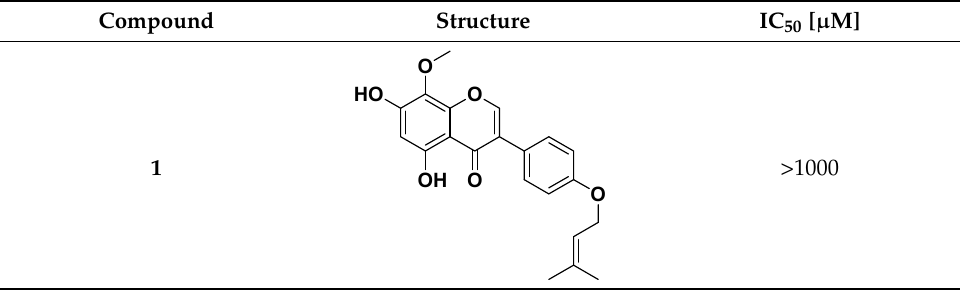
Table 1. Results of the topo II α HTS relaxation assay of the flavonoid hit compounds 1 – 8 .